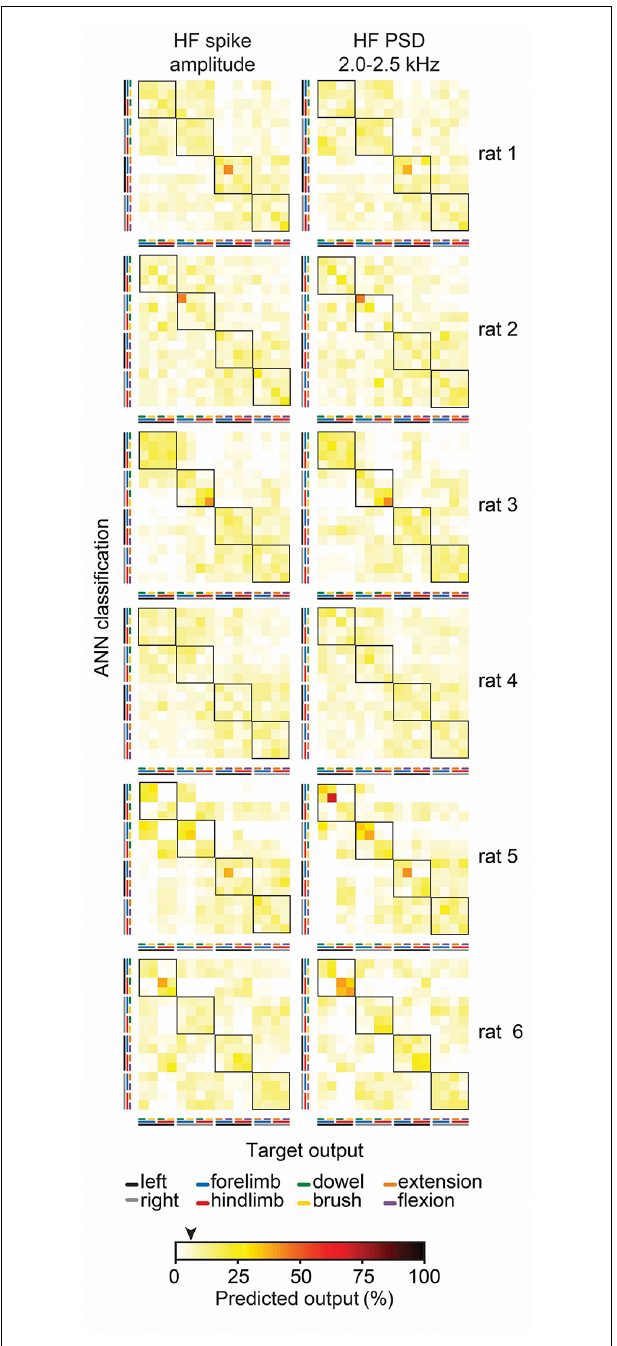
FIGURE 8 | Individual animal machine learning outcomes for 60 ms window at 1 s pre-stimulus. Each confusion matrix shows the machine learning outcomes for individual animals (rows) for two features (columns) which demonstrated feature-learnability significantly above chance levels at 1 s pre-stimulus. Note the similarity within animals, but lack thereof across animals. The black arrow on the color bar below confusion matrices indicates a chance level